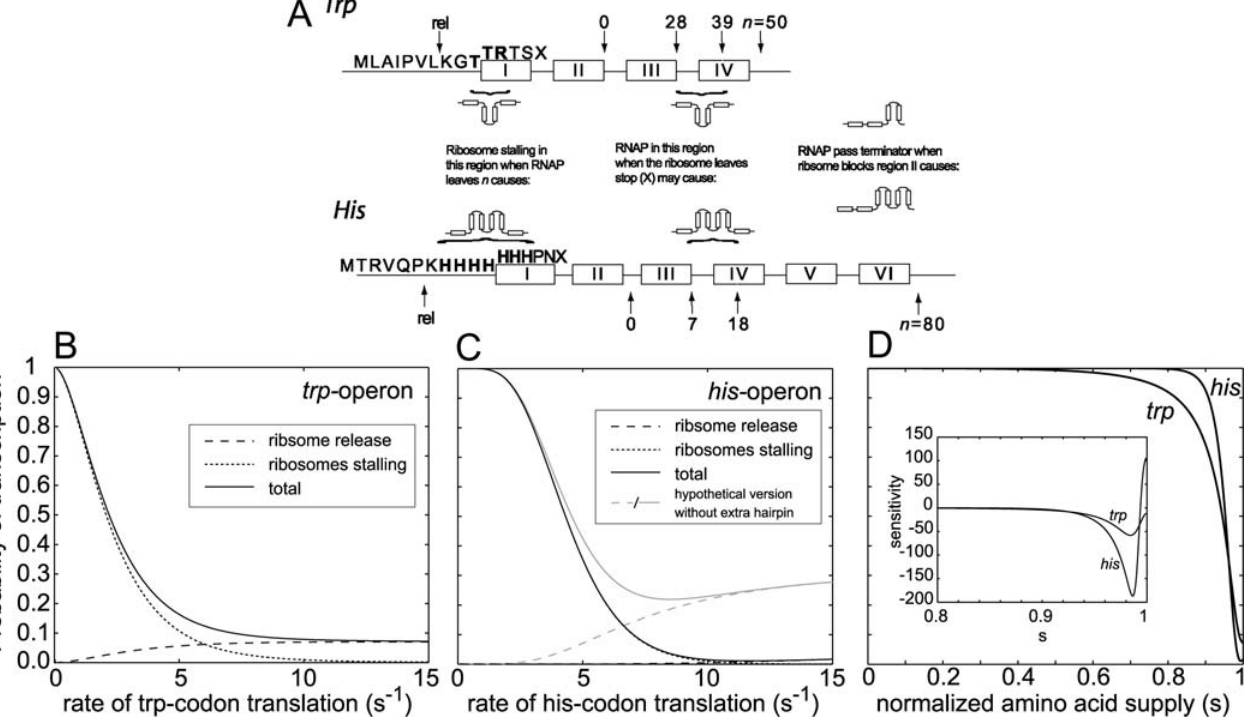
Figure 6. Attenuation Control of the his and trp Operons (A) The trp and his attenuation leader regions. For the trp mechanism, codon 3 and 4 after the ribosome has released the RNAP at ‘‘ rel ’’ are trp codons [2,17]. Ribosome stalling on codon 3, 4, or 5 leads to anti-terminator conformation [42]. If the ribosome releases from the stop codon (codon 8) after segment III is available for secondary structure formation (RNAP has transcribed nt 28 þ 8) but before more than half of segment IV is available (RNAP has transcribed nt 39 þ 8), the probability for anti-terminator formation is 50% [18]. The ‘‘ þ 8 ’’ are the bases that have been transcribed but are unavailable for secondary structure formation [43]. For the his mechanism, codon 2 to 8 after the ribosome has released the RNAP are his codons [2,44]. Ribosome stalling on any of these is assumed to lead to anti-terminator conformation. If the ribosome releases from the stop codon (codon 11) after segment III is available for secondary structure formation (RNAP has transcribed nt 7 þ 8) but before more than half of segment IV is available (RNAP has transcribed nt 18 þ 8), we assume a 50% chance to get anti-terminator formation. The transcription rate is 50 nt s (cid:1) 1 [45], the translation rate of codons other than trp or his is 15 s (cid:1) 1 [46], and the rate of ribosome release from the stop codon is 1 s (cid:1) 1 . (B,C) The probability of transcription ( y- axis) past the leader for trp and his operons as a function of the rate of translation of respective trp and his codons ( x- axis). The read-through probability is a sum of the probabilities for two mutually excusive events: ribosome stalling on the control codons while the RNAP escapes attenuation (dotted) or ribosome release from the stop codon before the termination hairpin is completed (dashed). In the trp case, the second event causes a high basal expression level. (D) The probability of transcription as a function of normalized supply of his and trp, respectively. The codon usage frequency is 1% for trp and 2% for his [28]. k max ¼ 15 s (cid:1) 1 . Insert : The sensitivity a Qs over the interval s ¼ 0.8 to 1.0. The positive sign of the sensitivity in gene expression for an increase in histidine supply in the narrow range of s ¼ 0.995–1.0 is due to reduced probability of ribosome release at the stop